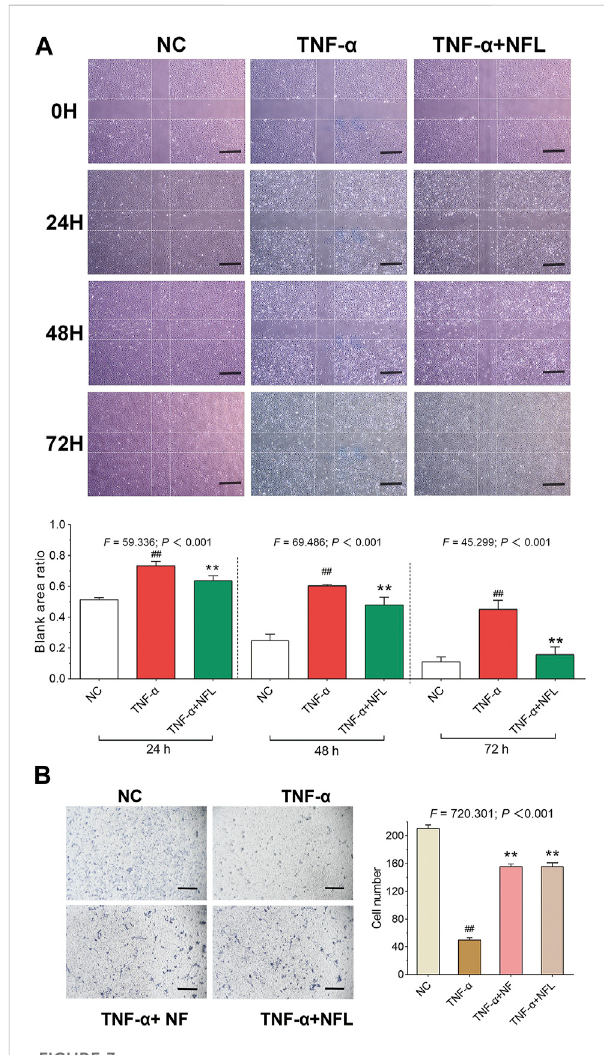
FIGURE 3 Wound healing and cell migration assays on chondrocytes with NFL treatment. (A) Wounding healing assay of chondrocytes with NFL treatment at 24, 48, and 72 h, and wound healing rate represented as the ratio of the scratched wound area at 24, 48, and 72 h treatment to the area without treatment (0 h). (B) Transwell assay of chondrocytes with NF and NFL intervention. Values are shown as mean ± SD. ## p < 0.01 vs . NC group; ** p < 0.01 vs . TNF- α group. NF, Nanofat. Scale bar = 200 μ